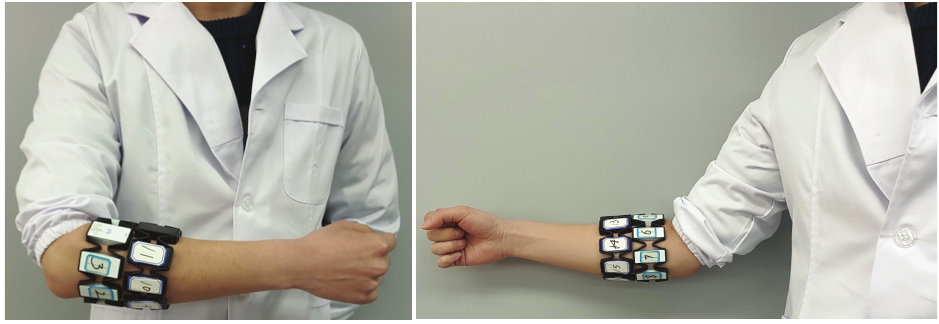
Figure 4. Acquisition setups for the two Myo